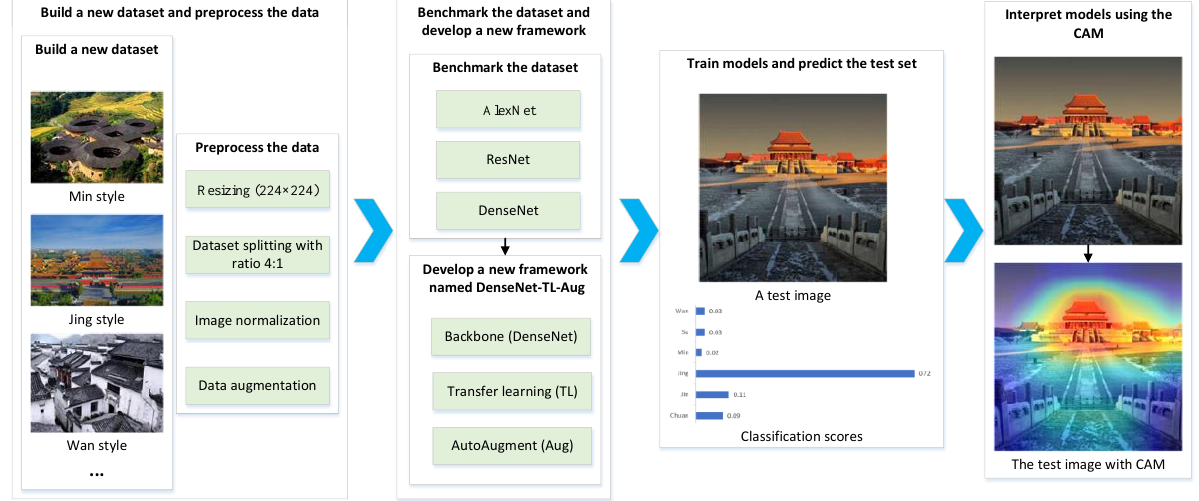
Figure 1. The proposed neural framework to achieve automatic classification and interpretation of architectural styles for CTSs.